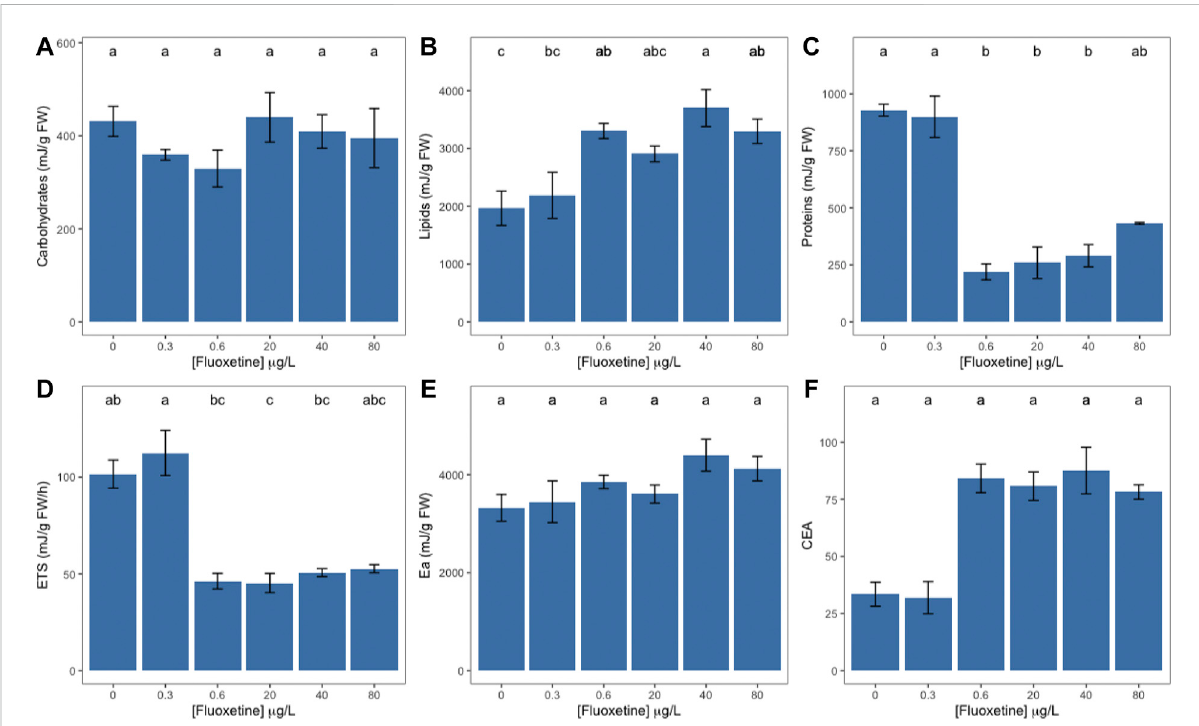
FIGURE 5 Ulva lactuca energetic metabolism at the mitochondria level of Ulva lactuca following a 48-h exposure to different fl uoxetine concentrations. (A) Carbohydrates. (B) Lipids. (C) Proteins. (D) Electron Transport System (ETS). (E) Available energy (Ea). (F) Cellular energy allocation (CEA). Average ± standard error, N = 3; different letters indicate signi fi cant differences at p <